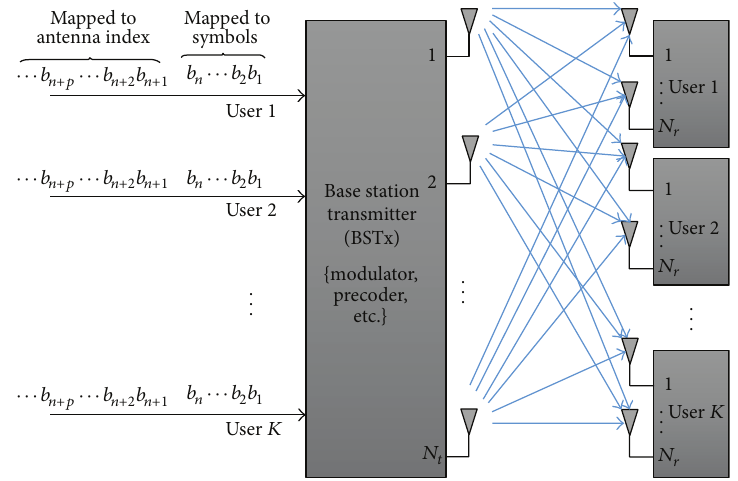
Figure 1: SM for multiuser MIMO